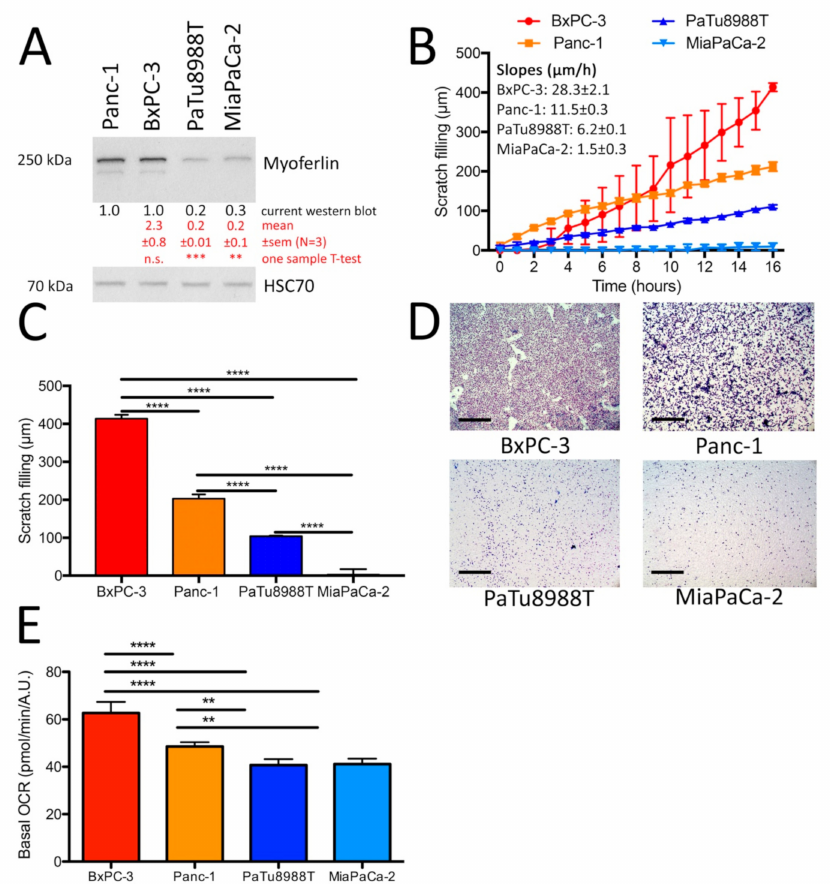
Figure 1. Myoferlin abundance is correlated with pancreatic cell migratory phenotypes and oxygen consumption rate. ( A ) Myoferlin relative abundance in Panc-1, BxPC-3, PaTu8988T, and MiaPaCa-2 cell lines. Heat Shock Cognate 71 kDa protein (HSC70) was used as an internal loading control. Myoferlin abundance was compared by one sample T-test to Panc-1 sample mean arbitrary fixed to 1. ( B ) Two-dimension migration kinetic assay (scratch assay) of BxPC-3, Panc-1, PaTu8988T, and MiaPaCa-2 cell lines. ( C ) End point (16 h) of two-dimension migration kinetic assay (scratch assay) of BxPC-3, Panc-1, PaTu8988T, and MiaPaCa-2 cell lines. ( D ) Three-dimension migration assay in Boyden’s chamber of BxPC-3, Panc-1, PaTu8988T, and MiaPaCa-2 cell lines (scale bar = 500 µ m). ( E ) Basal oxygen consumption rate (OCR) in BxPC-3, Panc-1, PaTu8988T, and MiaPaCa-2 cell lines. One